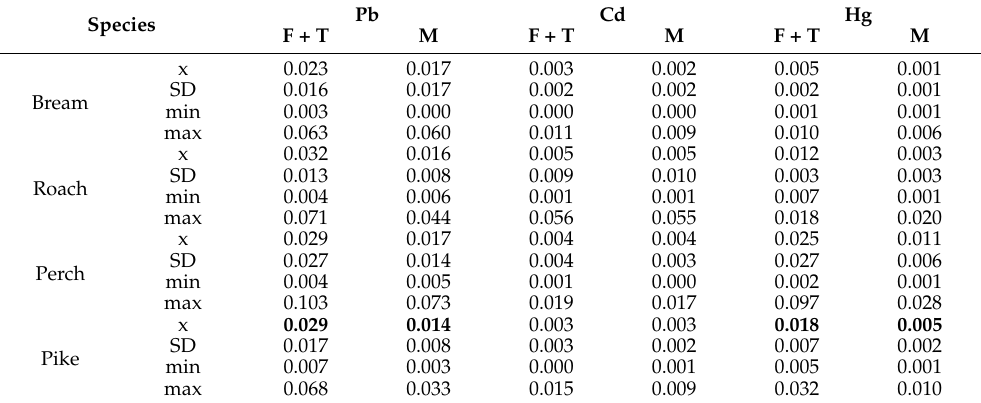
Table 3. Content of toxic elements in female fish gonads and testicles (F + T) and muscles (M) (mg/kg).